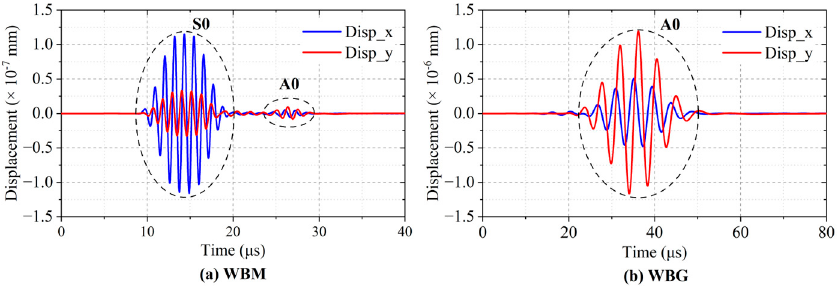
Figure 11. Horizontal and vertical displacements at P1 (60, 0) of the WBM and WBG models.